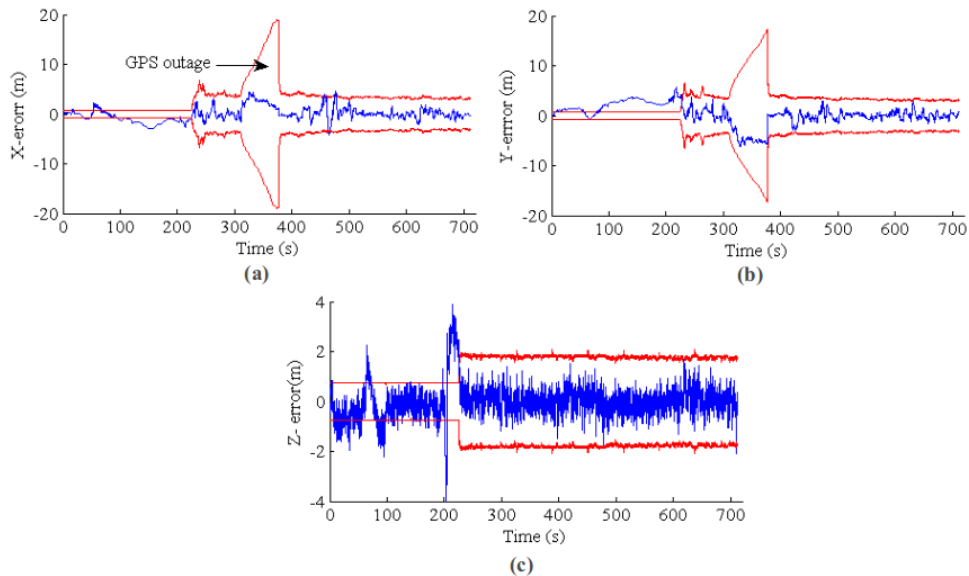
Figure 17. EKF state estimation for GPS outage from 300 s to 360 s. The blue line is the estimation error, and the red line is the 3 σ error band. As expected, the error covariance is slowly increased by fusing VO relative information. Furthermore, the state estimation is consistent and accurate. ( a – c ) The results for X , Y and Z ,